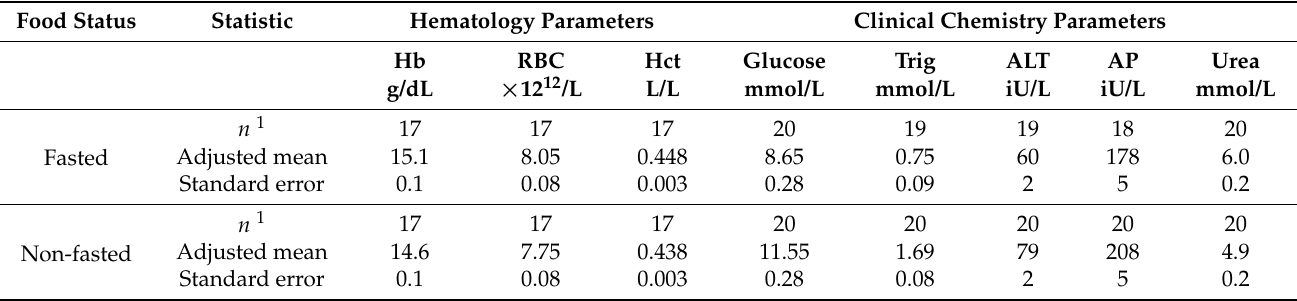
Table 2. Summary of hematology and clinical chemistry results in male Sprague Dawley